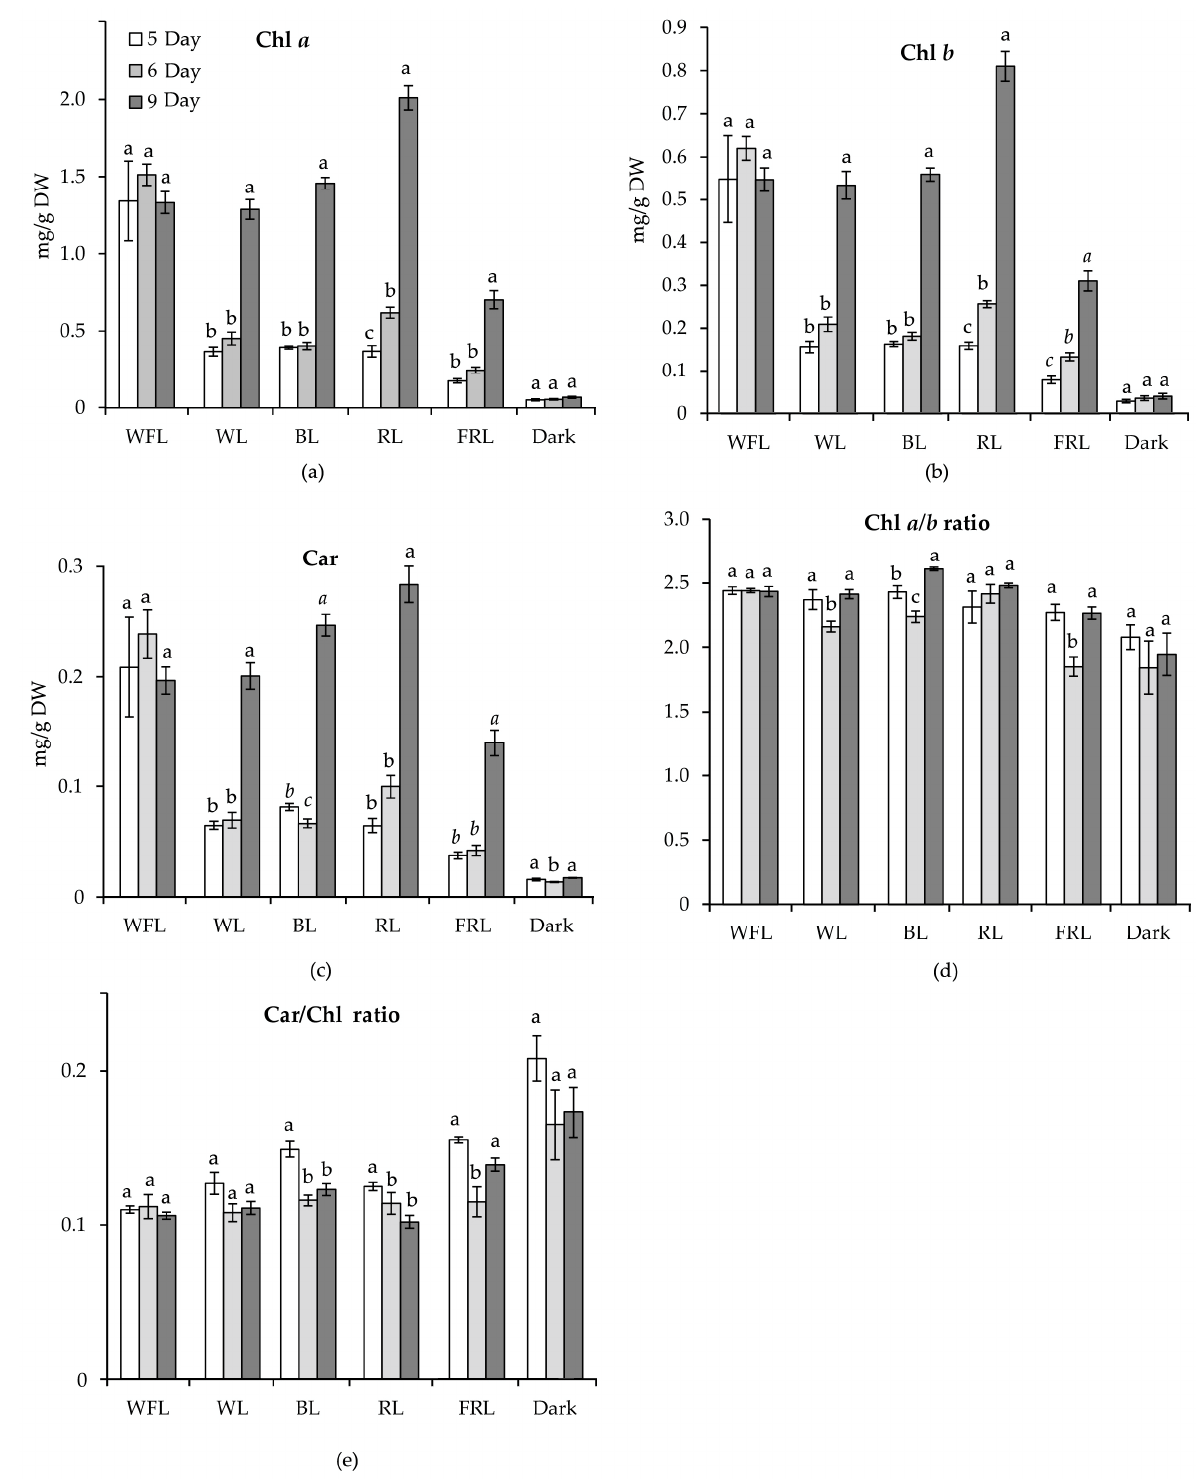
Figure 3. Content of photosynthetic pigments, as well as pigment ratio of Scots pine plantlets, on the 3rd, 5th and 9th day of the experiment under different light qualities. The contents of chlorophyll a , b and carotenoids are expressed in mg/g dry weight: ( a ) Chl a ; ( b ) Chl b ; ( c ) Car; ( d ) Chl a / b ratio; ( e ) Car/Chl. Different letters denote statistically significant differences in the means at p < 0.05 (ANOVA followed by Duncan’s method) between the experimental treatments. Different italic letters denote statistically significant differences in the means at p < 0.05 (Kruskal–Wallis ANOVA of the ranks followed by the Student–Newman–Keuls post hoc test) between the experimental treatments.